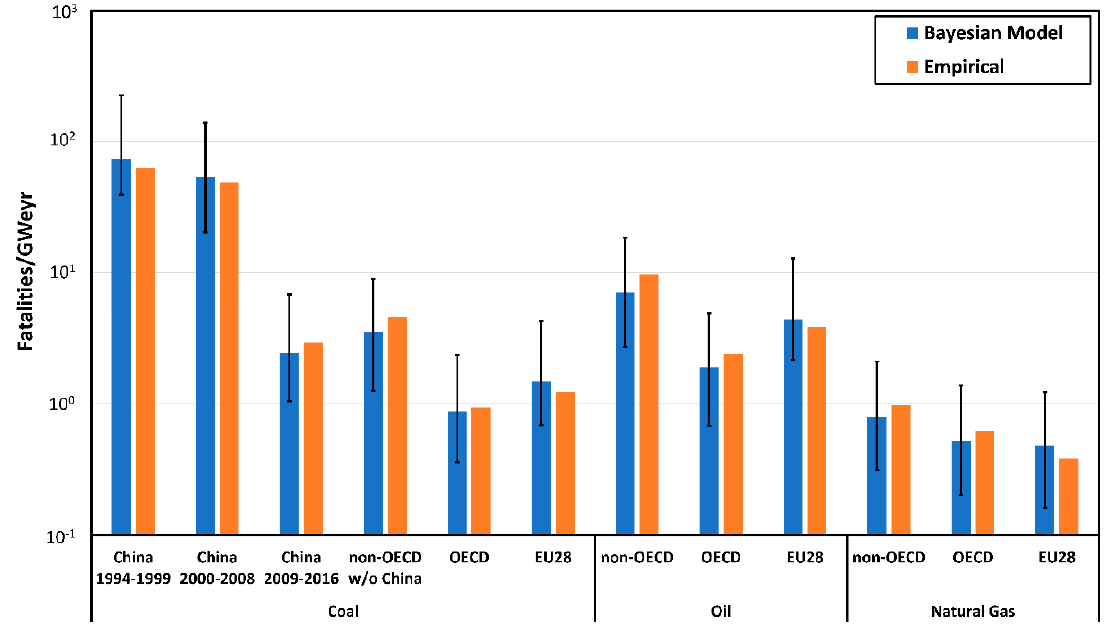
Figure 4. Risk for the Extreme Scenario in terms of fatalities per GWeyr modeled using a BMA and an empirical approach.